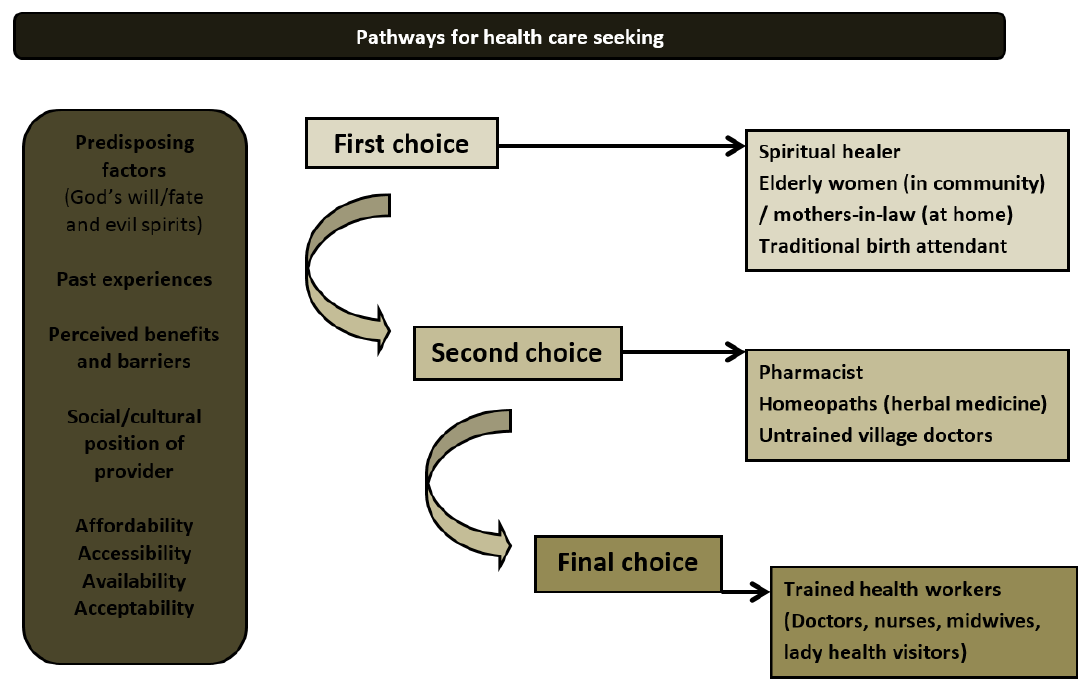
Figure 3. Pathways for health care